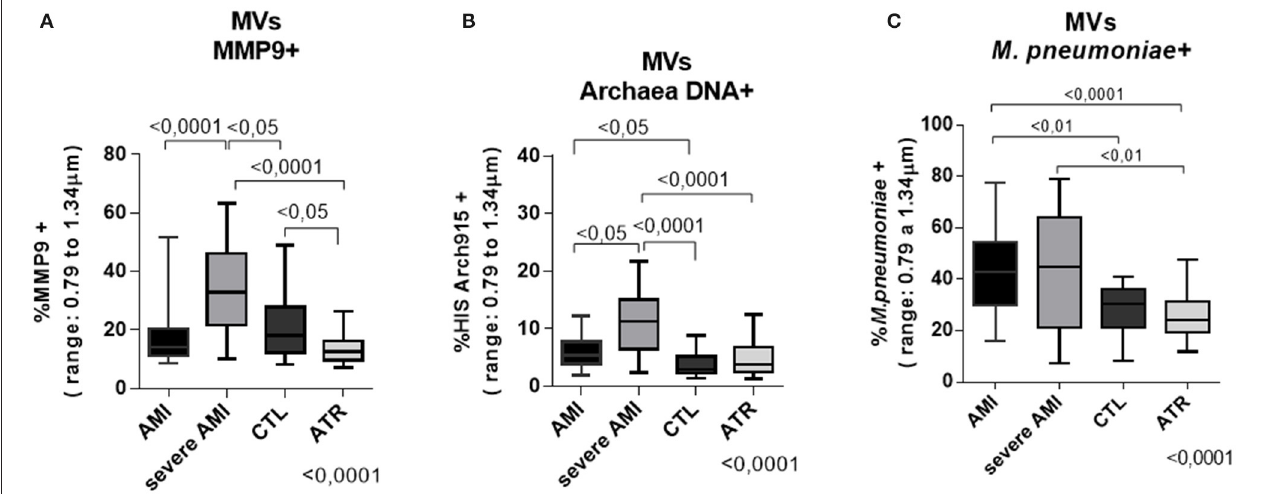
FIGURE 5 | Quantification by flow cytometry. The amount of MVs of infectious agents increases progressively according to the severity of atherosclerotic disease, and the symbiosis observed between archaea and M. pneumoniae observed in infarcted patients increases the number of positive MMP9 MVs, especially in severe cases. (A) % MMP9-positive MVs (B) % MVs with archaeal DNA (Arch915 probe) (C) % M. pneumoniae -positive MVs (size: 0.8–1.34 µ m—acquisition of 10,000 events) (AMI n = 40, severe AMI n = 34, CTL n = 34, ATR n = 40) (data are expressed as median and interquartile range 25–75%). Comparison by Kruskal-Wallis with Dunn applied as a post-test.